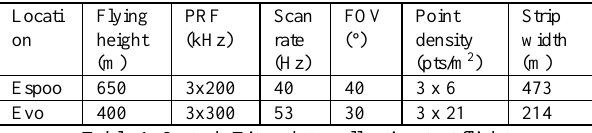
Table 1. Optech Titan data collection test flights.